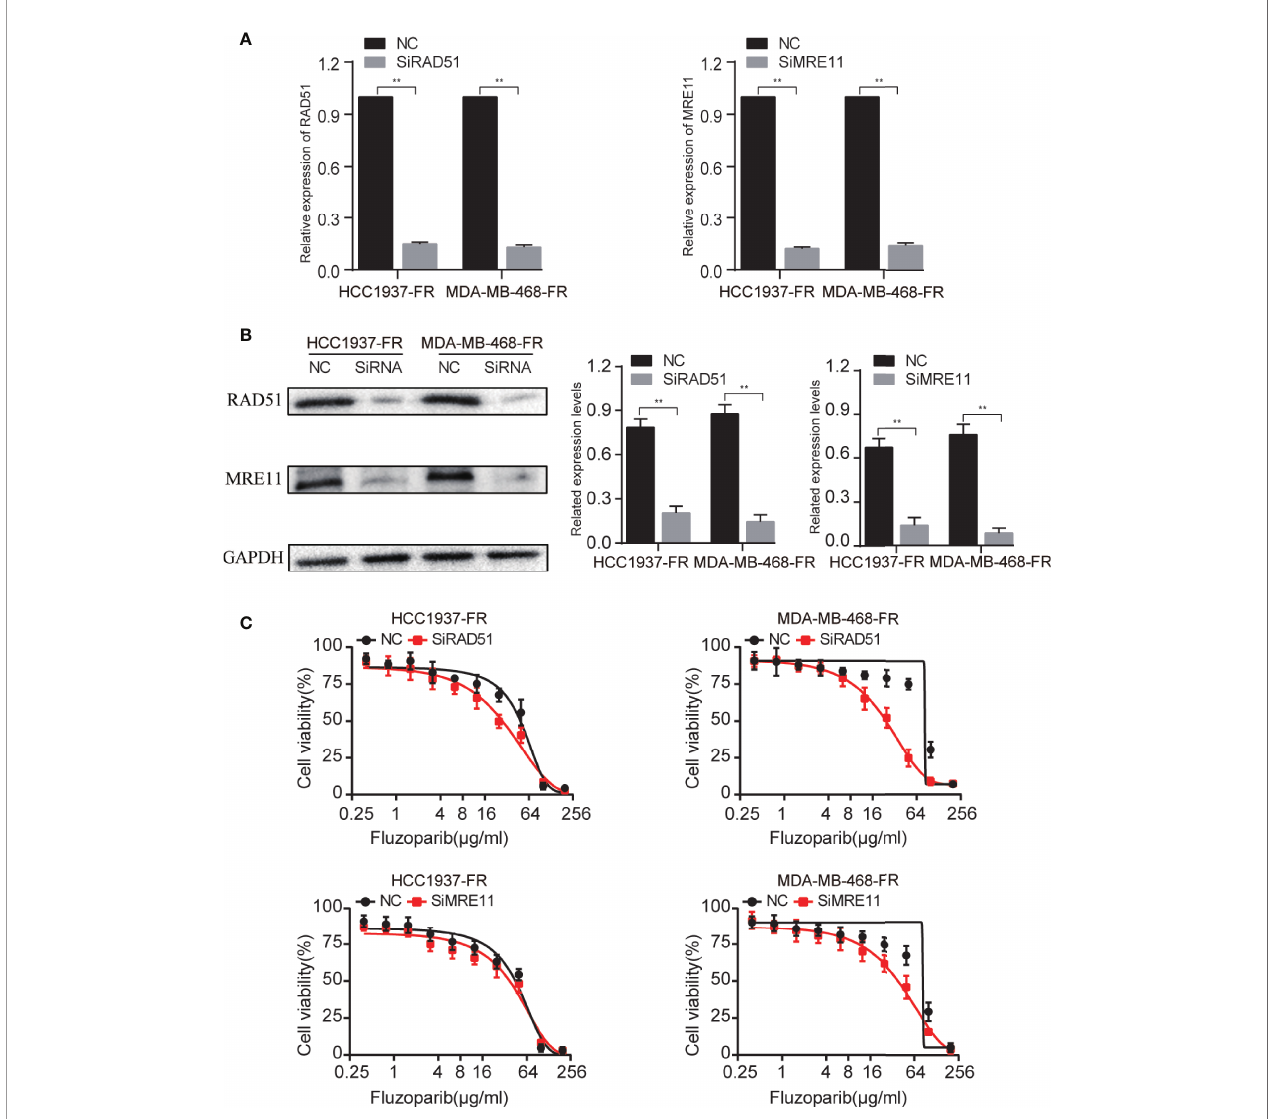
FIGURE 6 | Genetic suppression of RAD51 and MRE11 enhances the sensitivity of drug-resistant cells to fl uzoparib. (A) qRT-PCR was used to detect RAD51 and MRE11 after transfection with si-RAD51, si-MRE11, and NC in fl uzoparib-resistant cells. (B) Immunoblots of RAD51 and MRE11 in fl uzoparib-resistant cells transfected with si-RAD51, si-MRE11, and NC. (C) Dose response of fl uzoparib-resistant cells treated with fl uzoparib after transfection with si-RAD51, si-MRE11, and NC. NC, negative control. ** p <